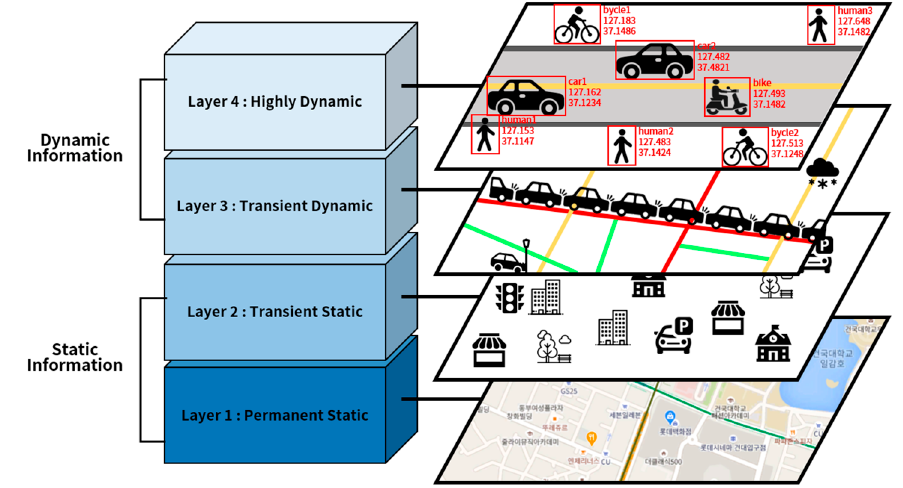
Figure 2. Concept of LDM.